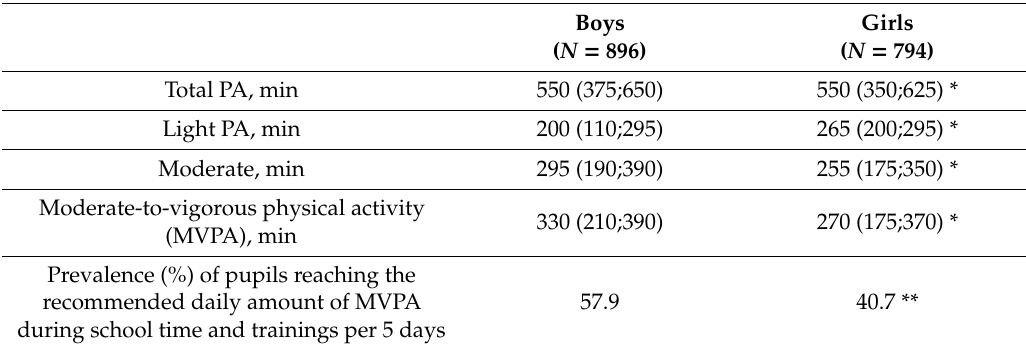
Table 5. Physical activity levels by